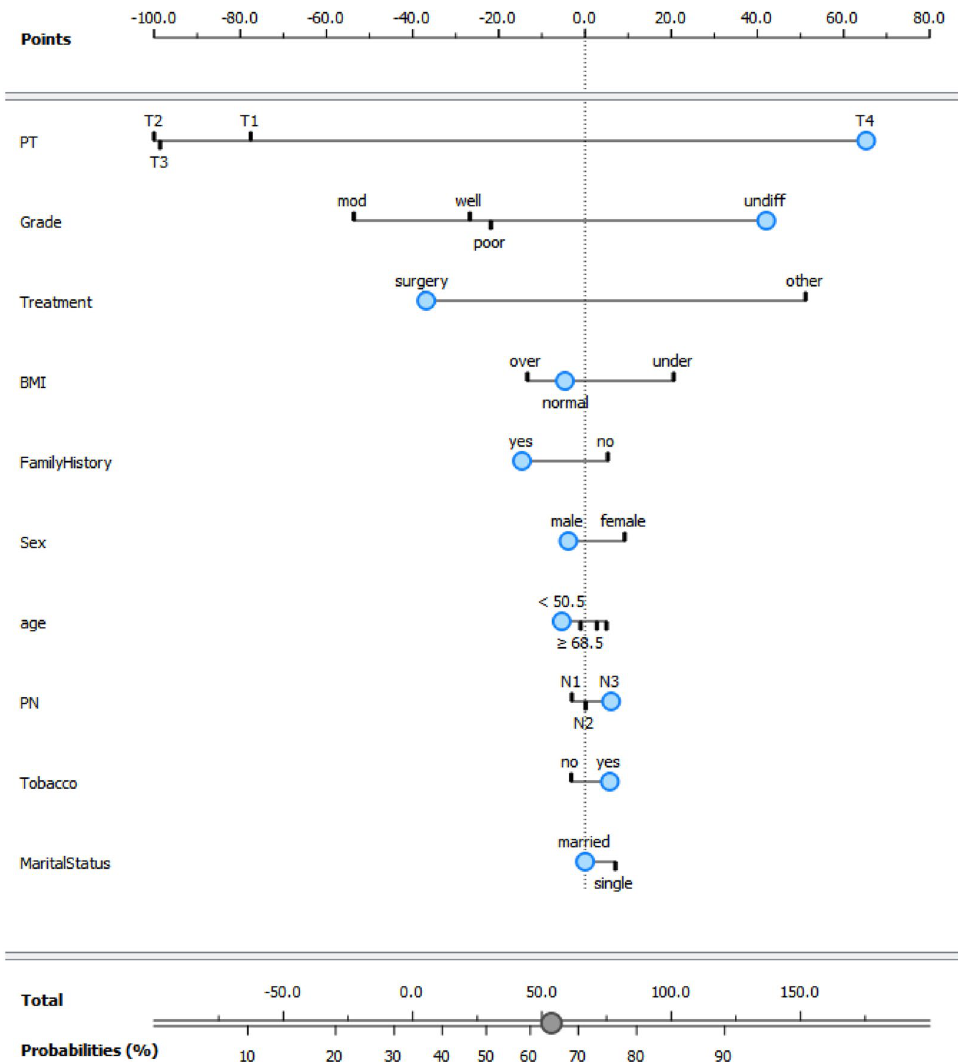
Figure 6. Nomogram for visualization of NB model for predicting metastasis in GC